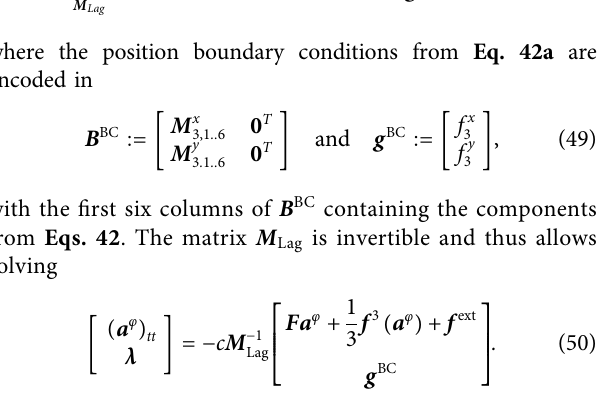
Frontiers in Robotics and AI |